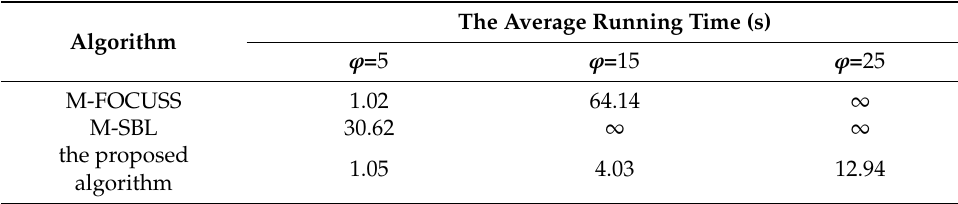
Table 5. Running time of different algorithms for a forward-looking